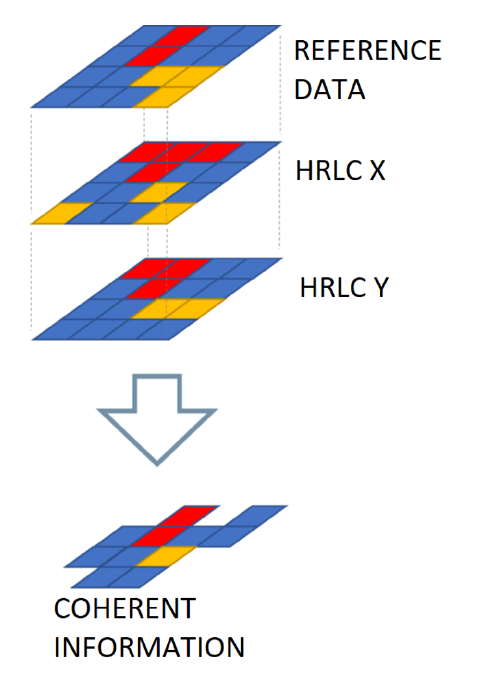
Figure 4: Extracting coherent information from multiple